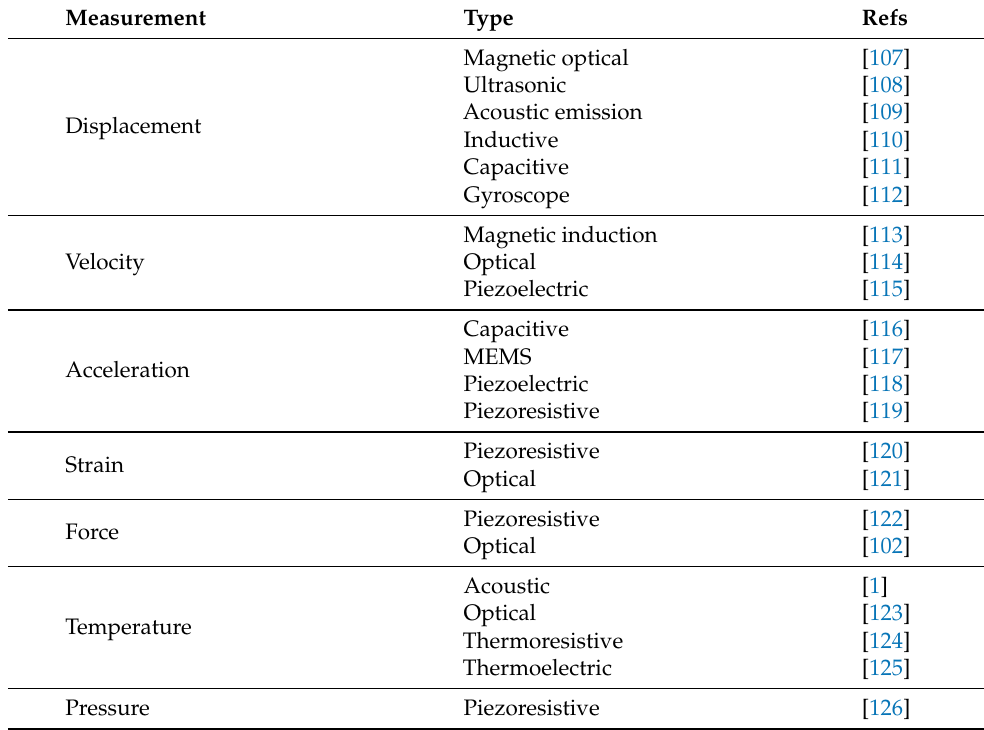
Table 7. Types of different sensors for damage detection of composite materials.